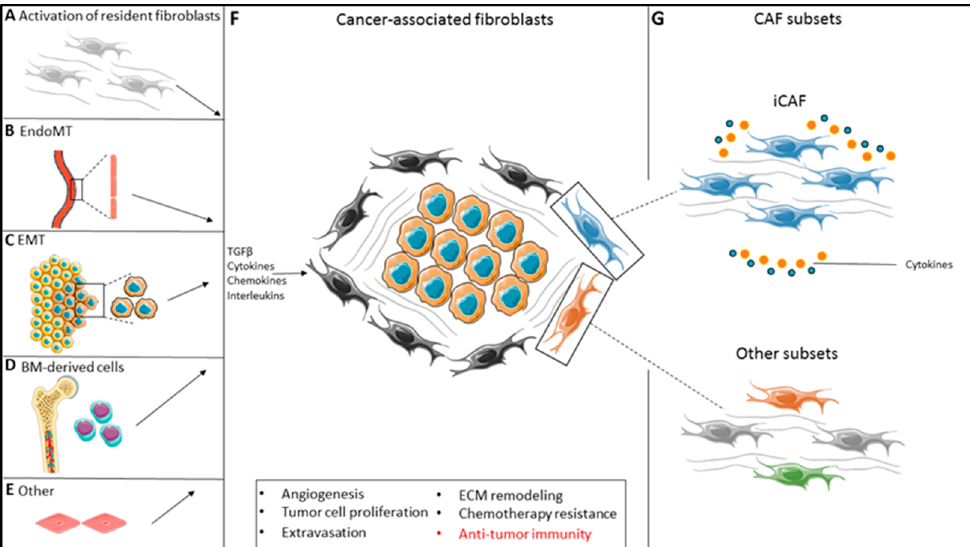
Figure 1. Fibroblast heterogeneity in the tumor-microenvironment. A–E . The origin of CAFs in the TME is diverse and they can be either derived from the activation of resident fibroblasts ( A ), endothelial-to-mesenchymal transition (EndoMT) ( B ), epithelial-to-mesenchymal transition (EMT) ( C ) bone-marrow derived mesenchymal cells ( D ) and/or other differential pathways (e.g., smooth muscle cell trans-differentiation ( E )). F–G . The function of these CAFs is diverse ( F ) and regulated by cues derived from within the TME, leading to formation of subsets with specific functions, including but not limited to, iCAFs ( G ). TGF- β , transforming growth factor β ; ECM, extracellular matrix; CAF, cancer-associated fibroblast; iCAF, inflammatory CAF.